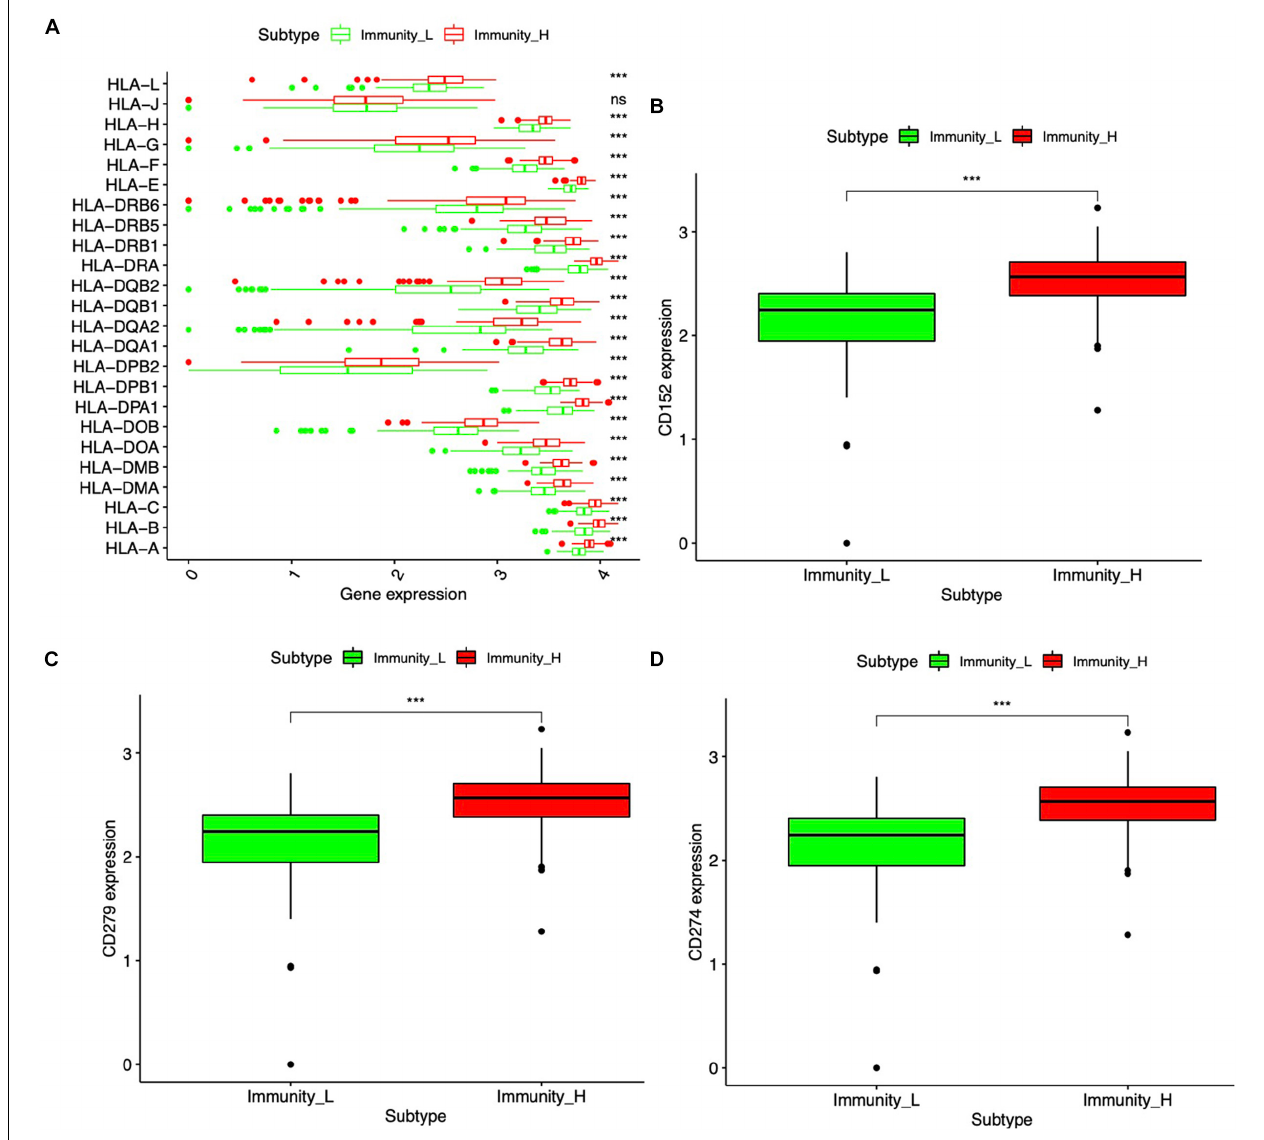
FIGURE 6 | HLA system and immune checkpoint between the high- and low-abundance immune groups. (A) Boxplot of the difference between high- and low-abundance immune groups in the HLA family. (B) Boxplot of the difference in CTLA-4 (CD152) between high- and low-abundance immune groups. (C) Boxplot of the difference in PD-1 (CD279) between high- and low-abundance immune groups. (D) Boxplot of the difference in PD-L1 (CD274) between high- and low-abundance immune groups. Wilcoxon rank sum was used for the significance test. *** p <